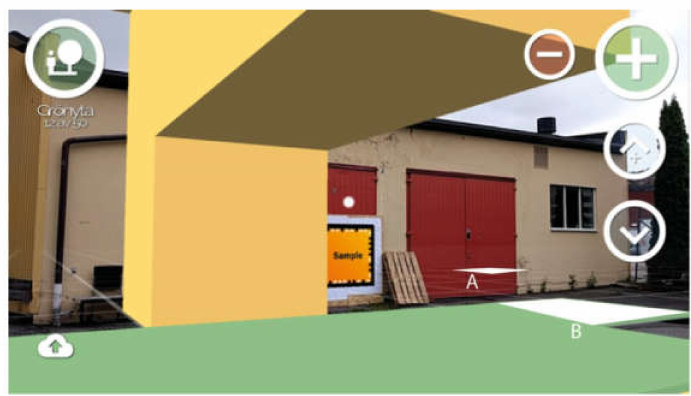
Figure 9. Screenshot of P6 shows the grid plane, and acute angle as the distance from the participant is greater, making it di ffi cult to localize